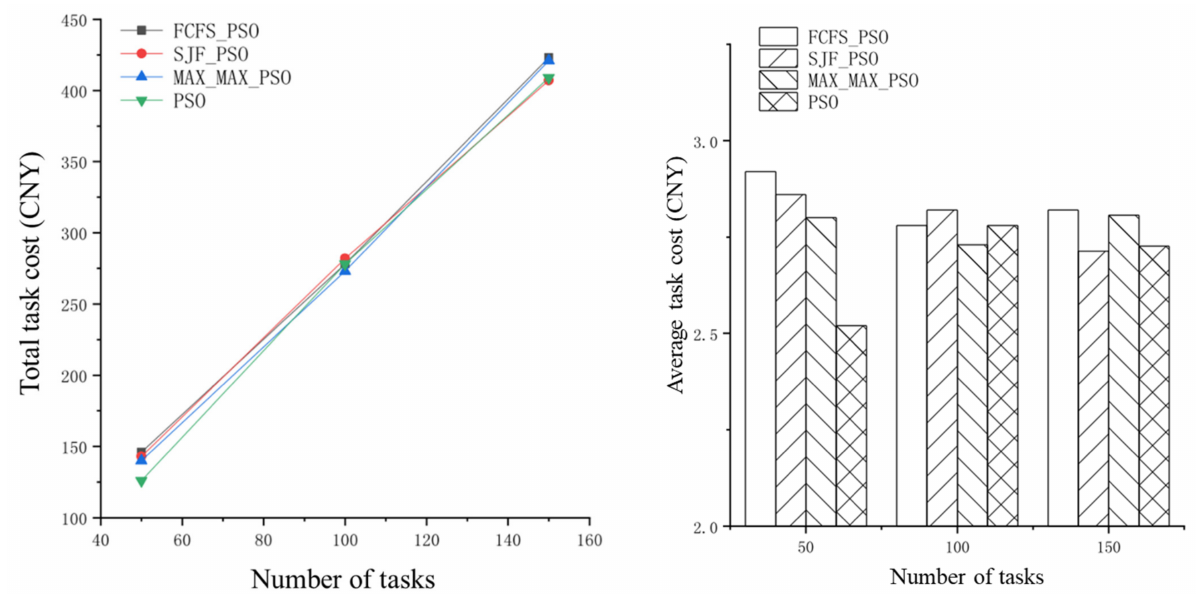
Figure 5. Results of task execution of different